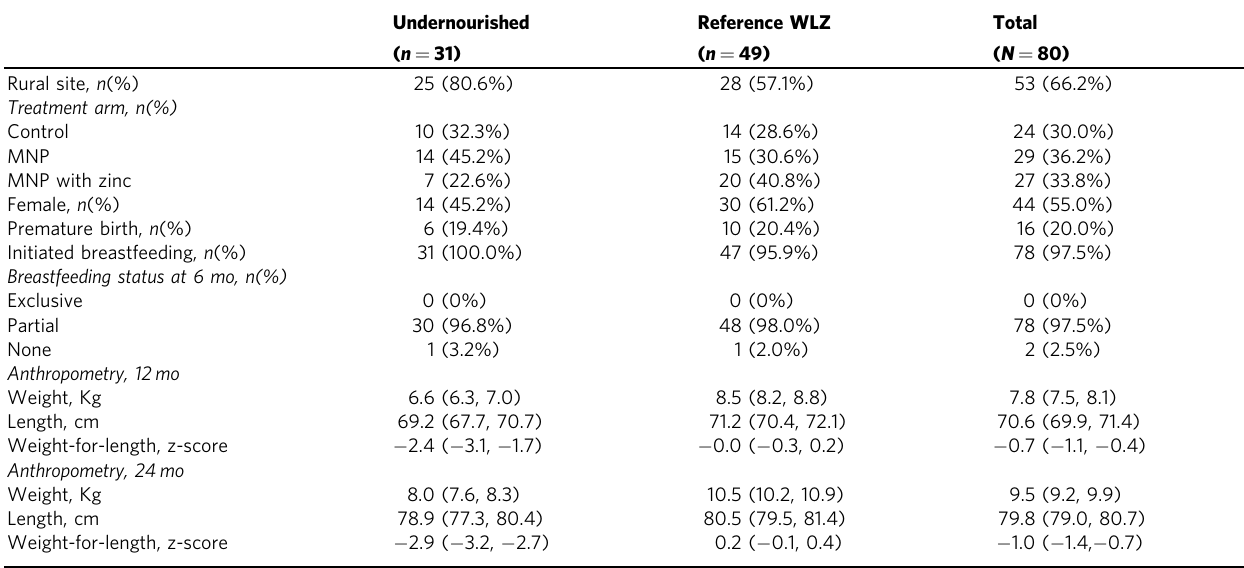
Table 1 Participant